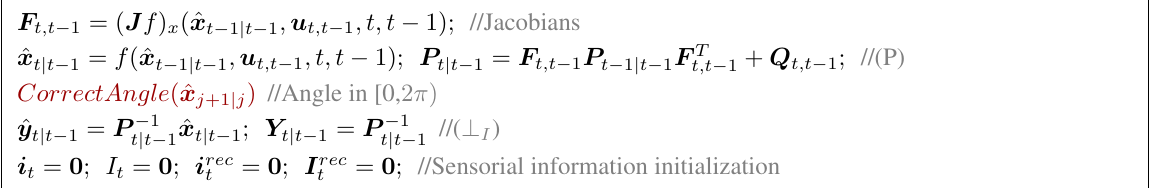
(measurement of sensor s with time stamp k s,k,t